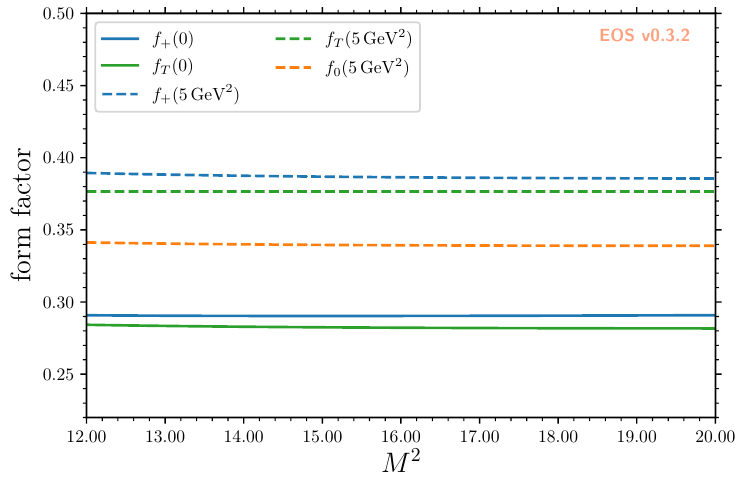
Figure 2 . The dependence of the form factors f + (in blue), f 0 (in orange), and f T (in green) on the Borel parameter M 2 . We exemplify this dependence for two different choices of q 2 : 0 GeV 2 (solid lines), and 5 GeV 2 (dashed lines). The form factor f 0 coincides with f + at q 2 = 0 , and is therefore not depicted at this